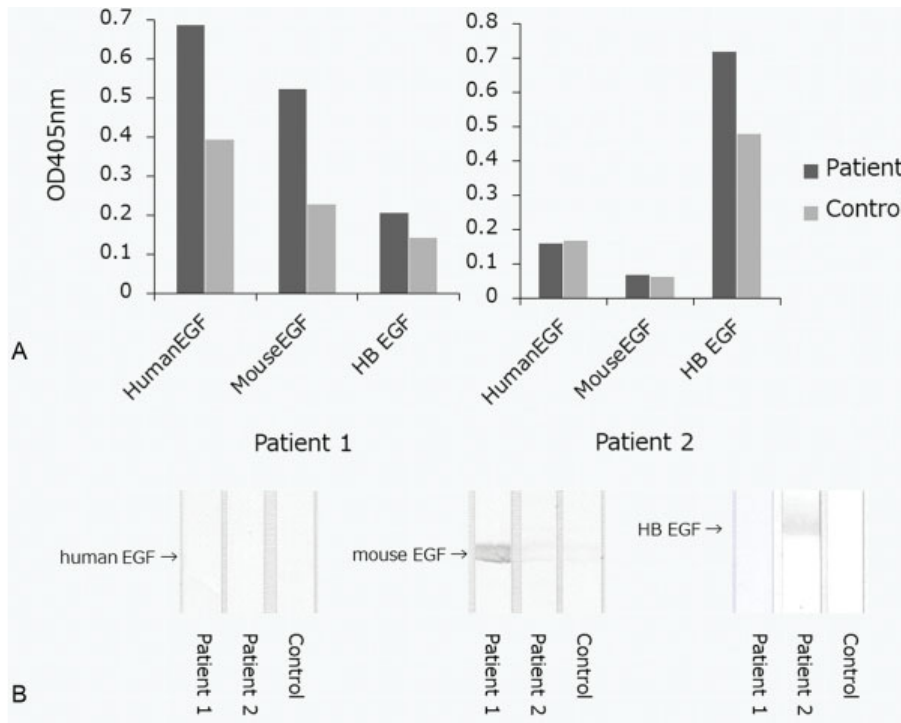
Fig. 6. A representative experiment showing binding of ASQ41-bound autoantibodies puri fi ed from patient plasma to recombinant mouse EGF, human EGF, and HB-EGF. ( A ) ELISA was performed using amino plates coated with 10 µM recombinant mouse EGF, human EGF, or HB-EGF. The eluate (1:10) from the ASQ41-af fi nity column that contained autoantibodies to ASQ41 that were puri fi ed from anti-ASQ41-positive patient plasma or normal control plasma was applied, followed by an alkaline-phosphatase-conjugated secondary antibody. The absorption at 405 nm was then measured. ( B ) SDS-PAGE was performed using a polyacrylamide gradient gel (5 – 20%). Recombinant human EGF, mouse EGF, or human HB-EGF (30 μ M solution) under reducing conditions was applied to each lane. Subsequent transfer to a PVDF membrane was performed for 20 minutes at 0.1 amps. We used 1% BSA inTBS (pH 7.3) to block the membrane for 1 hour. Incubation was performed with the eluate (1:10) from the ASQ41-af fi nity column that contained autoantibodies to ASQ41 that were puri fi ed from anti-ASQ41-positive patient plasma or normal control plasma for 2 hours, followed by three washes in 0.05% Tween 20/TBS. The membranes were exposed to horseradish-peroxidase- conjugated polyclonal antibodies against human IgM for 1 h, followed by washing as described above. The immunoreactive bands